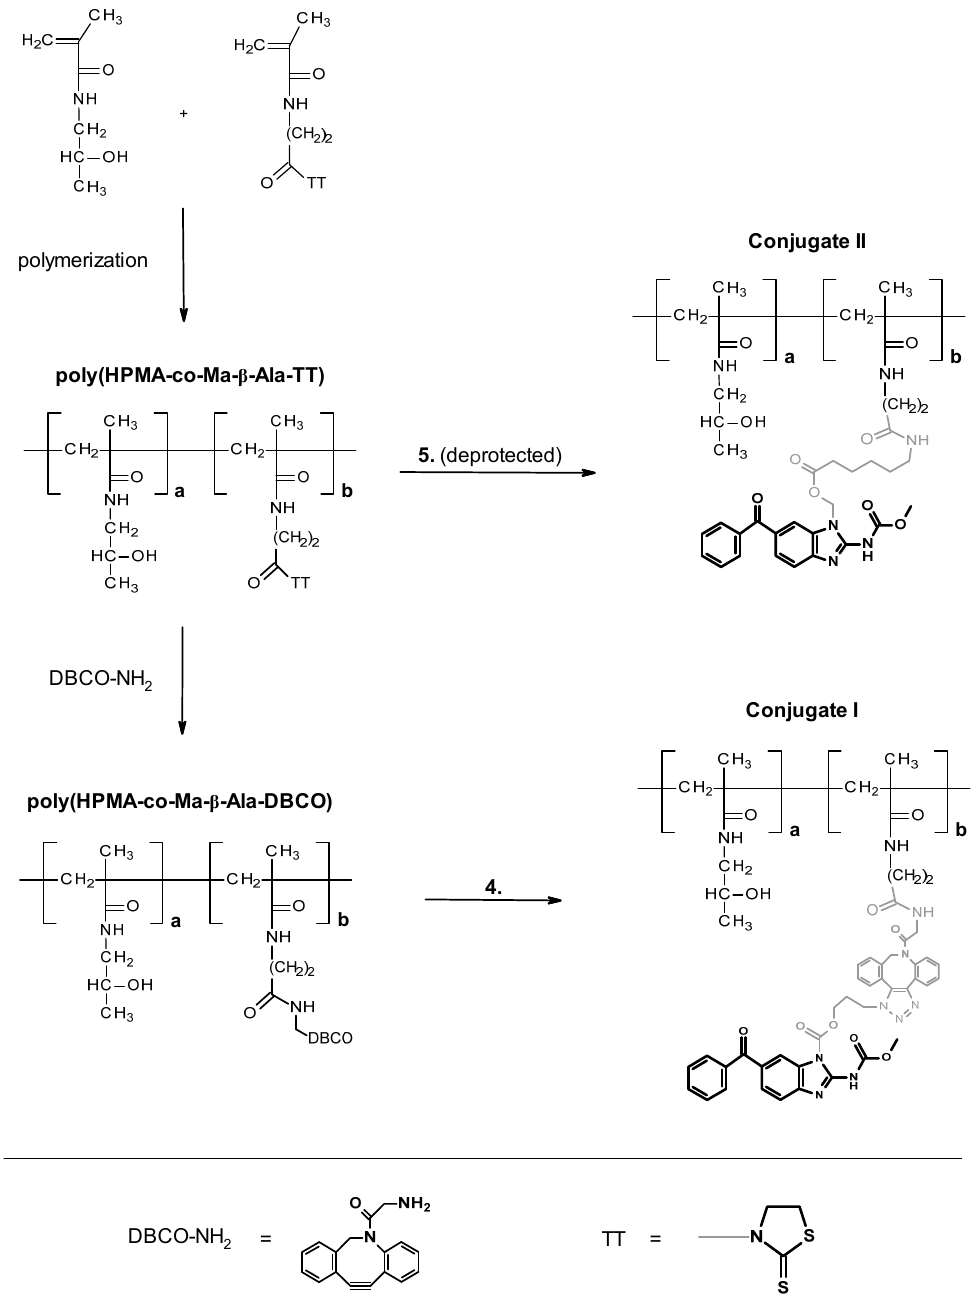
Figure 4. Synthesis of HPMA-based mebendazole polymer conjugates I (carbamate linker) and II (ester linker).